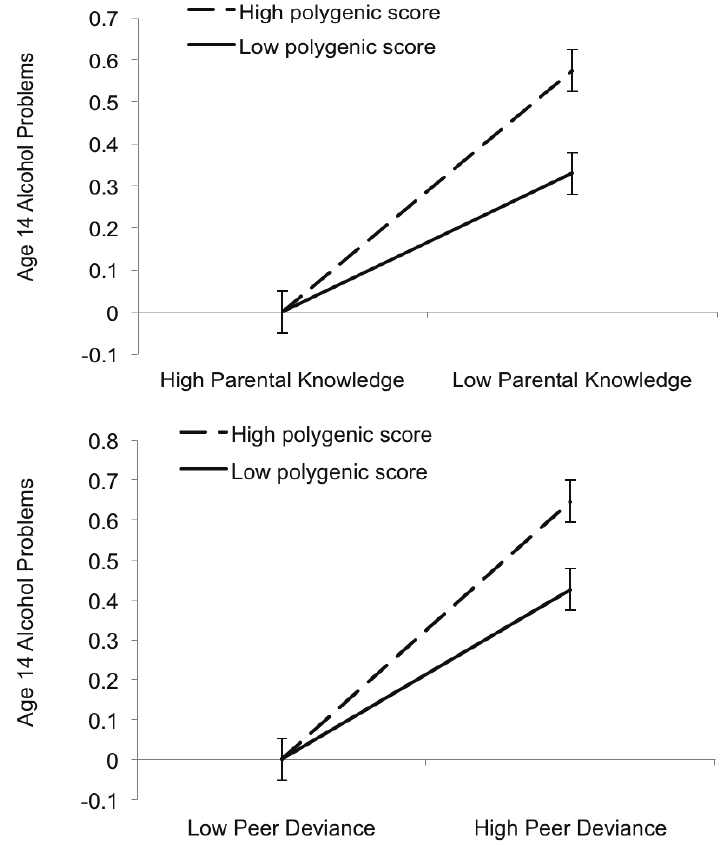
Figure 2. Parental knowledge (top) and peer deviance (bottom) moderate polygenic risk to predict age 14 alcohol problems in FinnTwin12. Interactions are plotted as predicted values based on the moderated multiple regression equation for age 14 alcohol